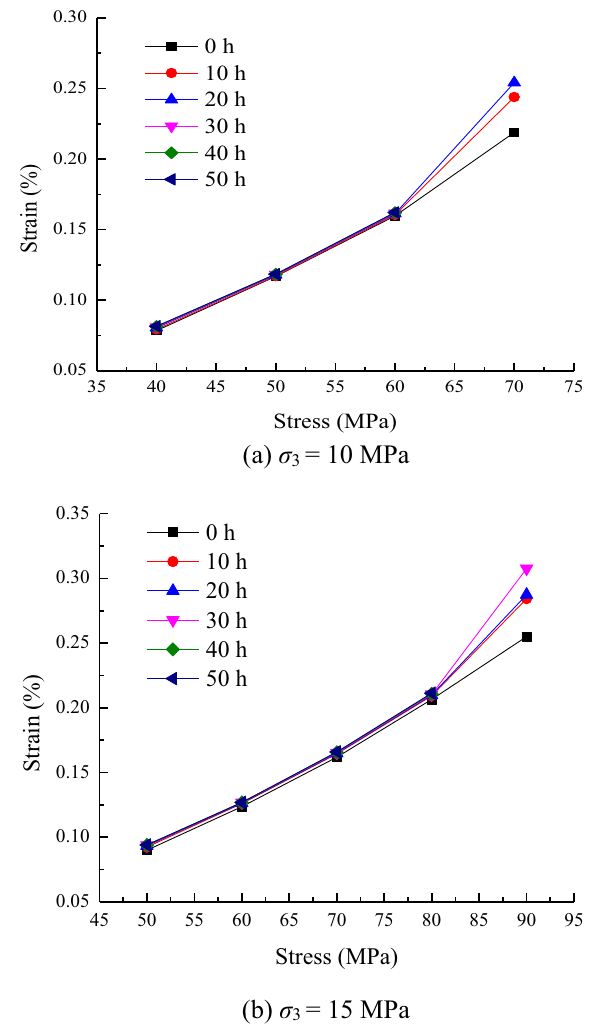
Figure 8. Isochronous stress–strain